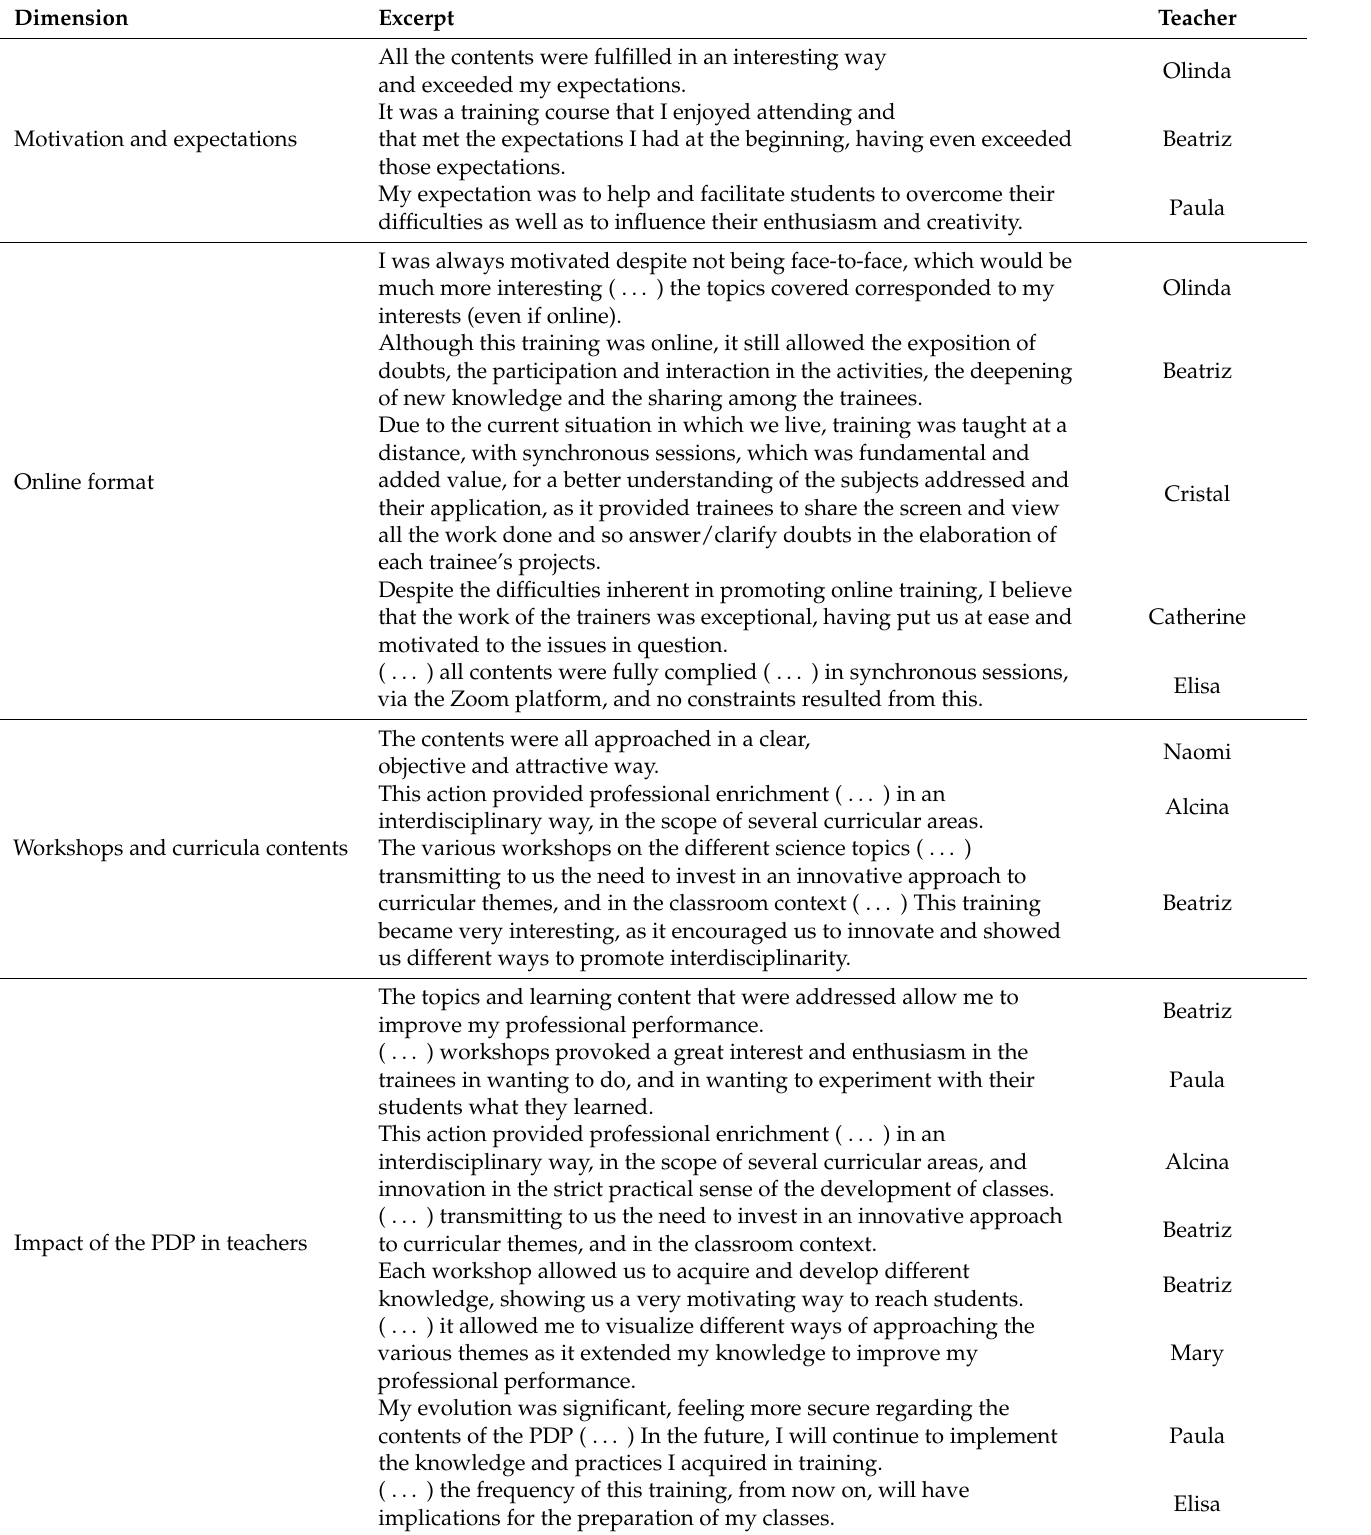
Table 6. Dimensions of teachers’ perceptions about the PDP in the school year